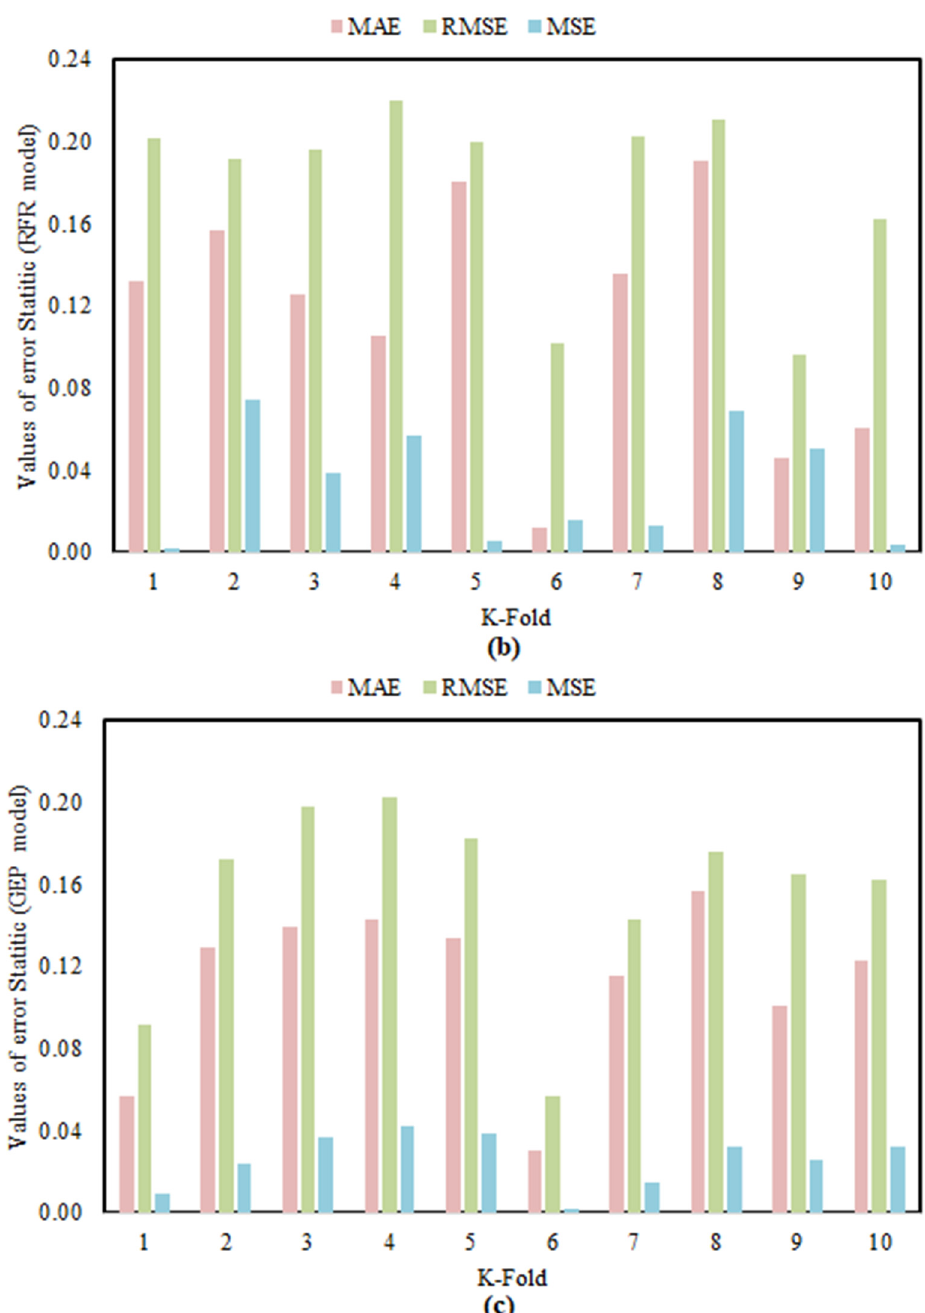
Figure 8. Statistical metrics used in KFCV ( a ) Coefficient of determination (R 2 ), ( b ) Error statistic of RFR model ( c ) Error statistic of GEP model.